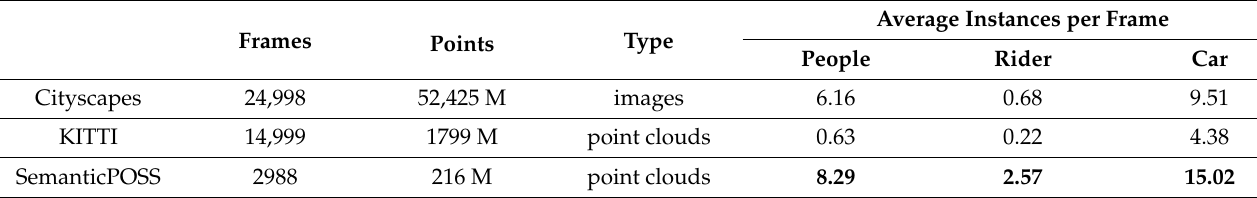
Table 3. Comparison of